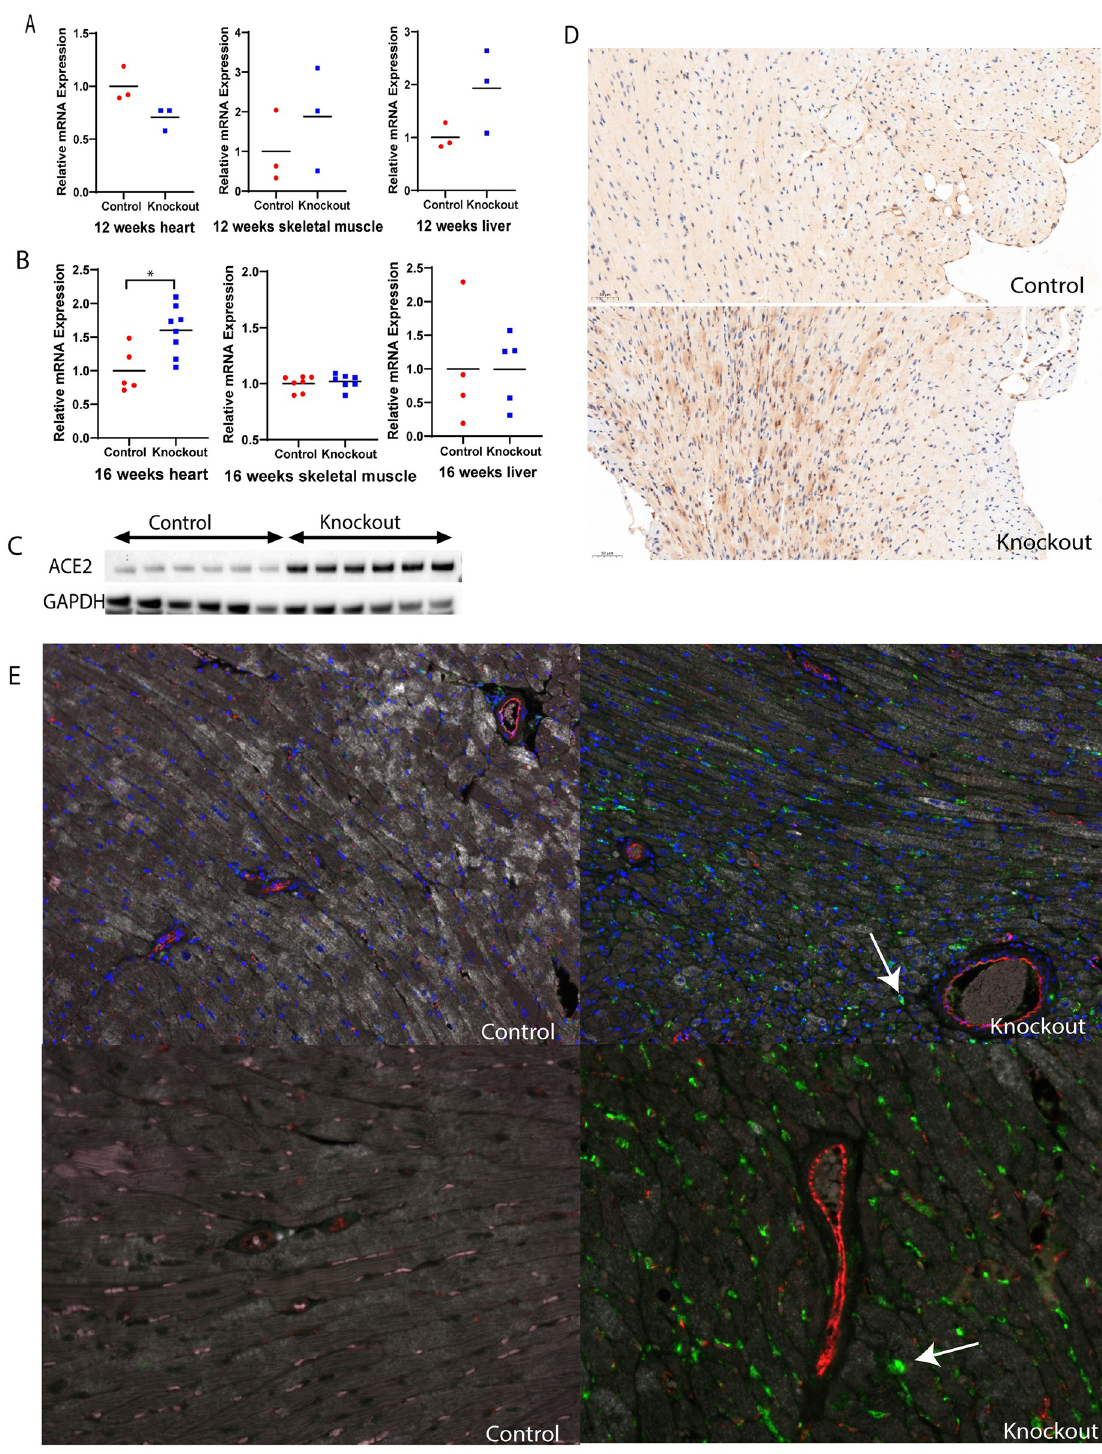
Fig 5. Angiotensin-Converting Enzyme 2 highly expressed in heart. (A) Ace2 gene expression in 12 weeks heart, skeletal muscle and liver. n = 3 mice per group. (B) Ace2 gene expression in 16 weeks heart, skeletal muscle and liver. n = 4–8 mice per group. (C) ACE2 high expressed in protein level in all knockout group mice. n = 6 mice per group. (D) Immunohistochemistry results of ACE2 staining. n = 3 mice per group. (E) Staining CD31 (red colour), CD68 (pink colour) and ACE2 (green colour) colocalization using confocal to acquire image, 20X magnification and 40X magnification. n = 3 mice per group. For (A-B), Mann-Whitney U -test was used to compare the control to the knockout groups. Significant levels were set to p < 0.05( � ), p < 0.01( �� ), p < 0.001( ��� ).